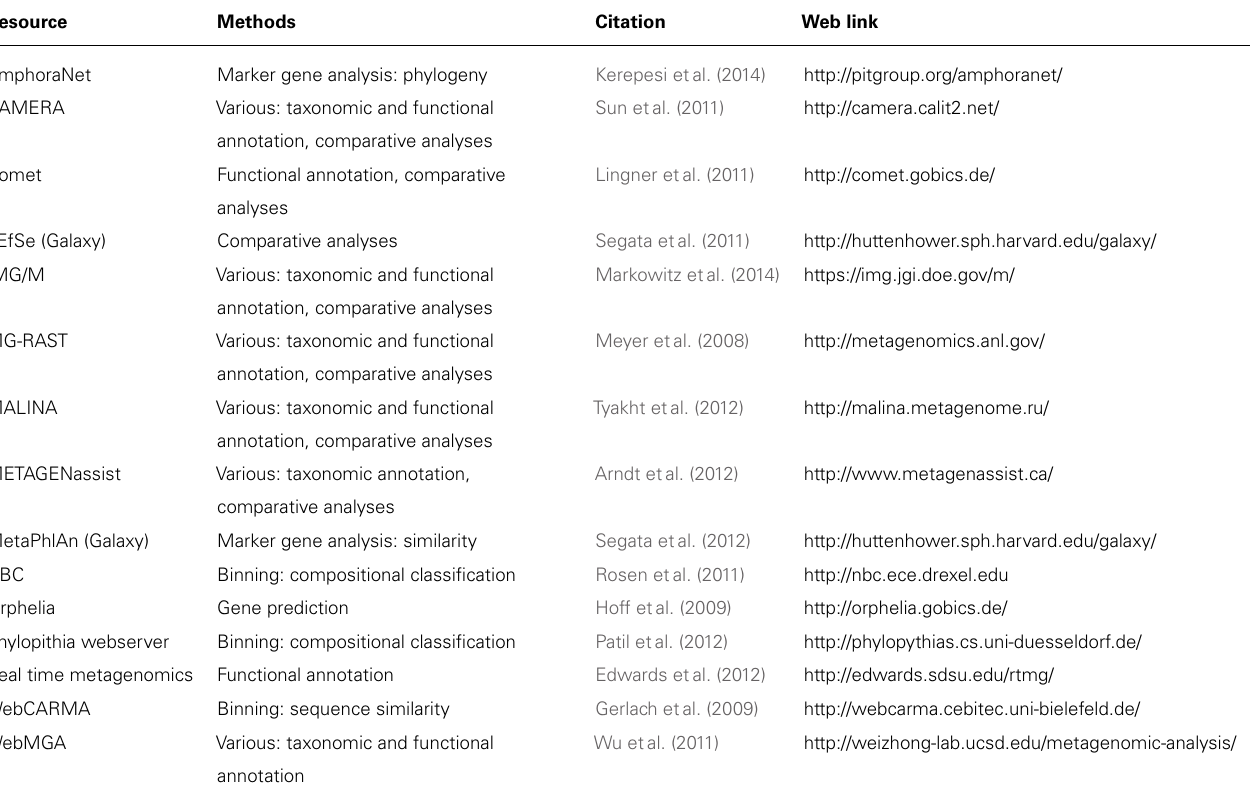
Table 1 |Web-based metagenomic analysis